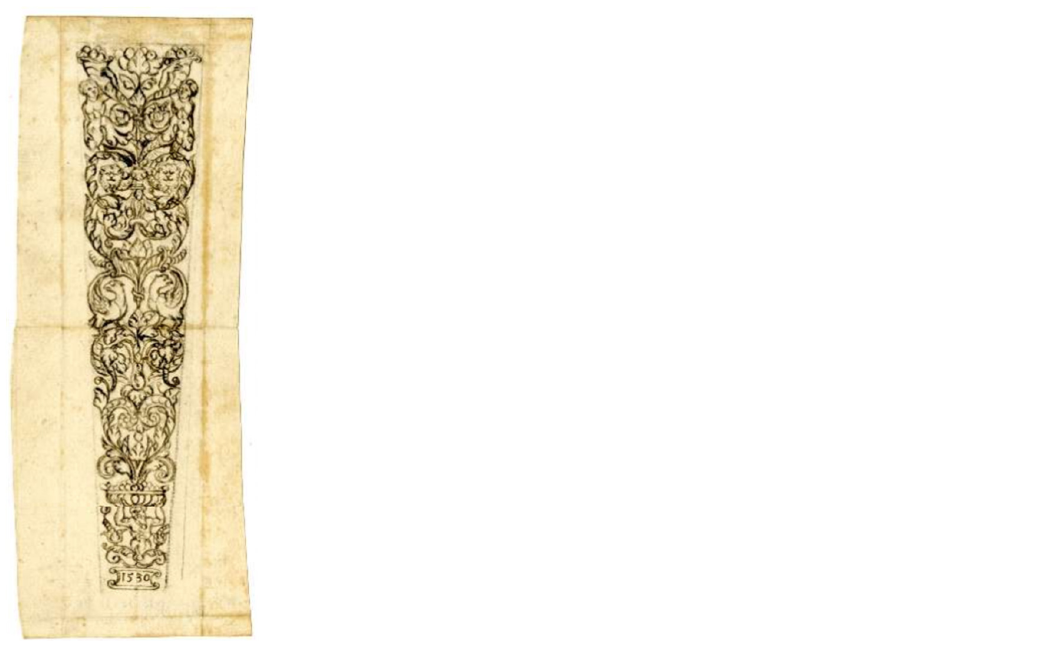
Figure 10. Design for a panel in the style of Heinrich Aldegrever, from the ‘Jeweller’s Pocket Book’ 1530. British Museum 1978, 1216.51 .